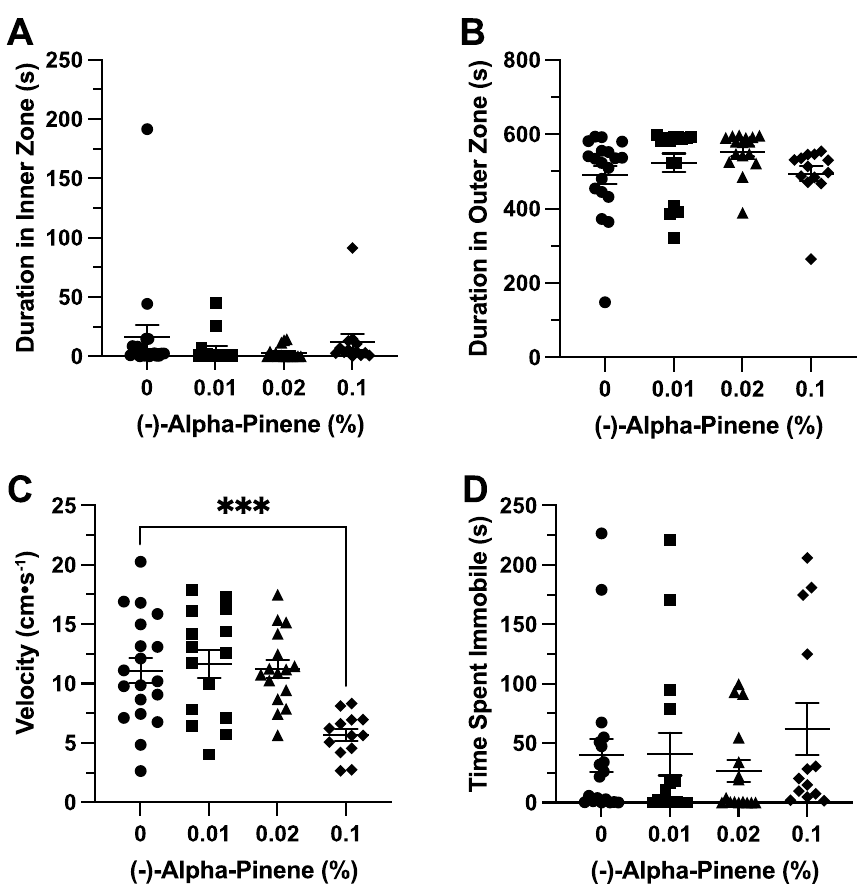
Figure 5. The effects of (−)-alpha-pinene administration in the novel object approach test. Average duration of time fish spent in the ( A ) inner and ( B ) outer ‘thigmotaxis’ zone during the novel object approach test. Fish locomotion was quantified in the novel object approach test by measuring ( C ) swimming velocity and ( D ) time spent immobile. All data are presented as mean ± S.E.M. Significant differences between controls and (−)-alpha- pinene treated groups are indicated by ***( p <